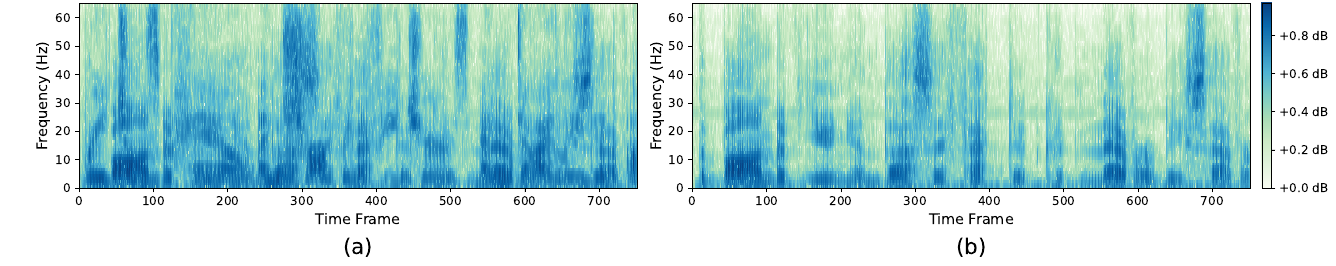
Figure 2. The magnitude spectrogram of the noisy audio and the target clean speech. The x -axis represents the time frame, the y -axis represents the frequency, and the unit of color scale is dB. ( a ) The magnitude spectrogram of the noisy audio; ( b ) the magnitude spectrogram of the target clean